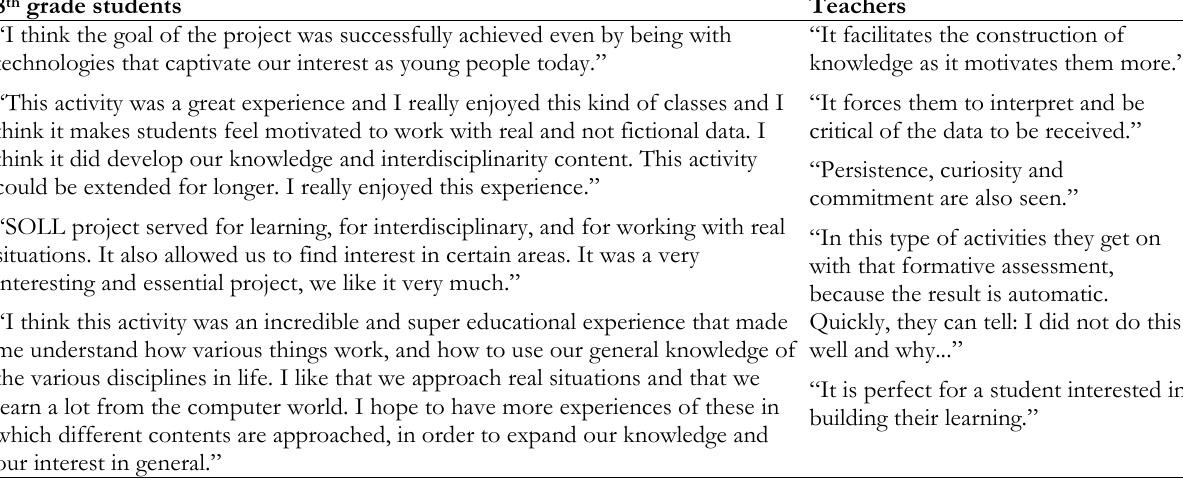
Table 2. Some opinions of students and teachers about the SOLL Project